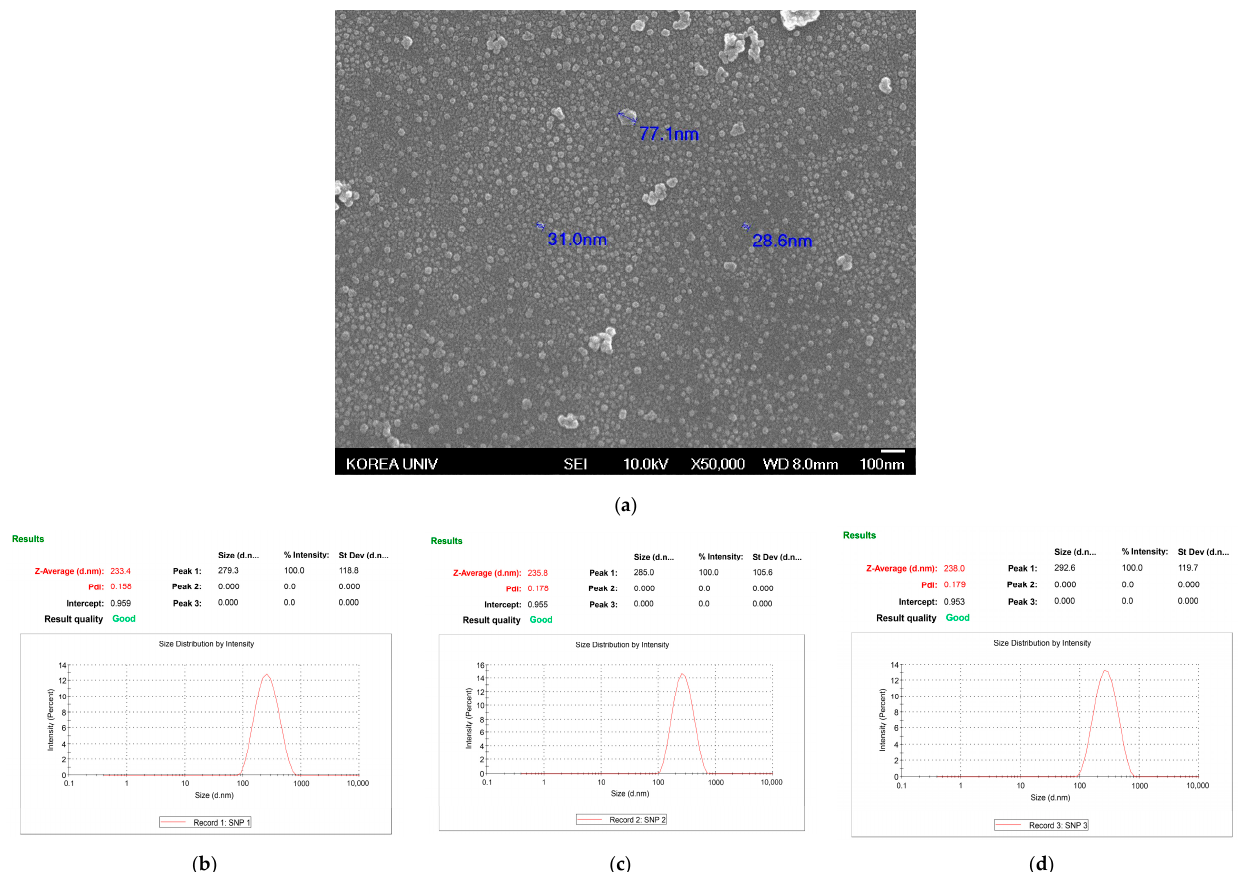
Figure 3. Particle properties of AgNPs using A. catechu. ( a ) Scanning electron microscopy (SEM) image and particle size distribution curves at ( b ) 24 h, ( c ) 48 h, and ( d ) 72